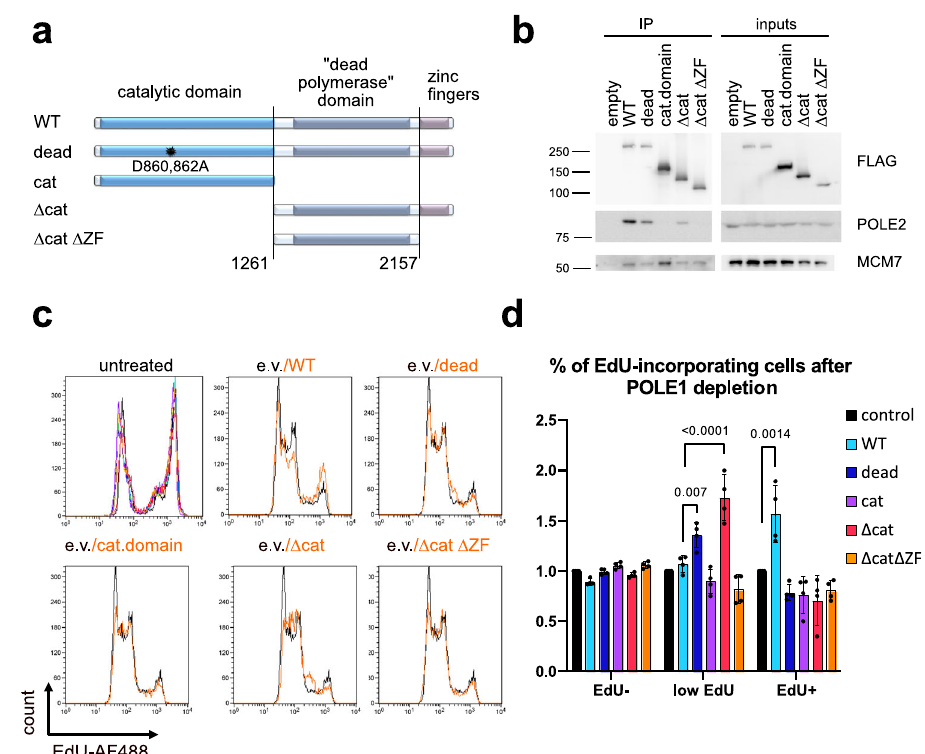
Fig. 5 | C-terminal non-catalytic part of POLE1 is critical for replication initia- tion. a Schematic representation of POLE1 constructs used in the study: wild-type protein,catalyticallydeadproteinwithmutationsD860A,D862A,catalyticdomain of POLE1 (aa1 – 1261), C-terminal half of POLE1 (without the catalytic domain, aa 1262 – 2305), C-terminal part of POLE1 without the zinc- fi nger domain (aa 1261 – 2151). b 293FT cells were transfected with an empty vector or the